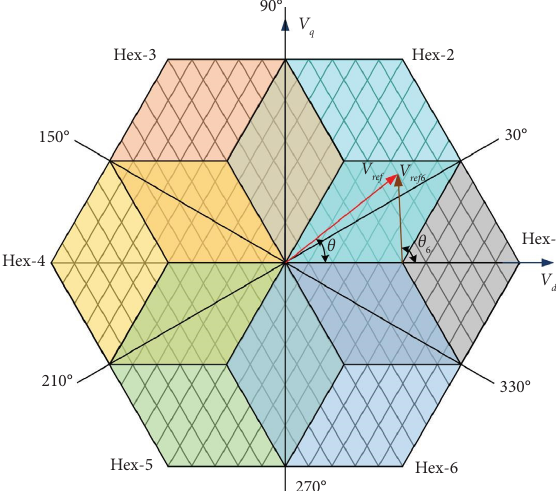
Figure 2: 11L SVD with reference vector mapping and its disin- tegration to 6L